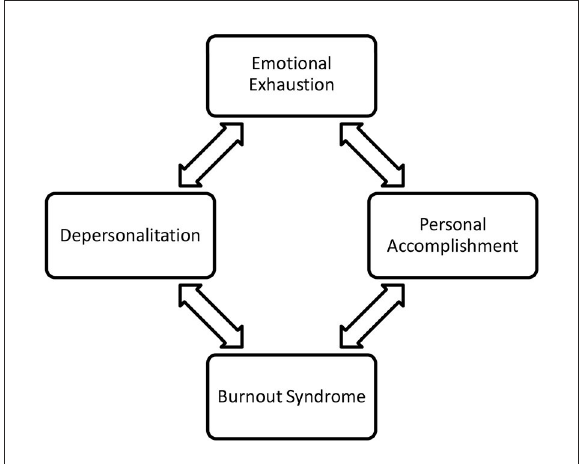
FIGURE1 The measurement of experienced burnout. Source: Maslach and Jackson